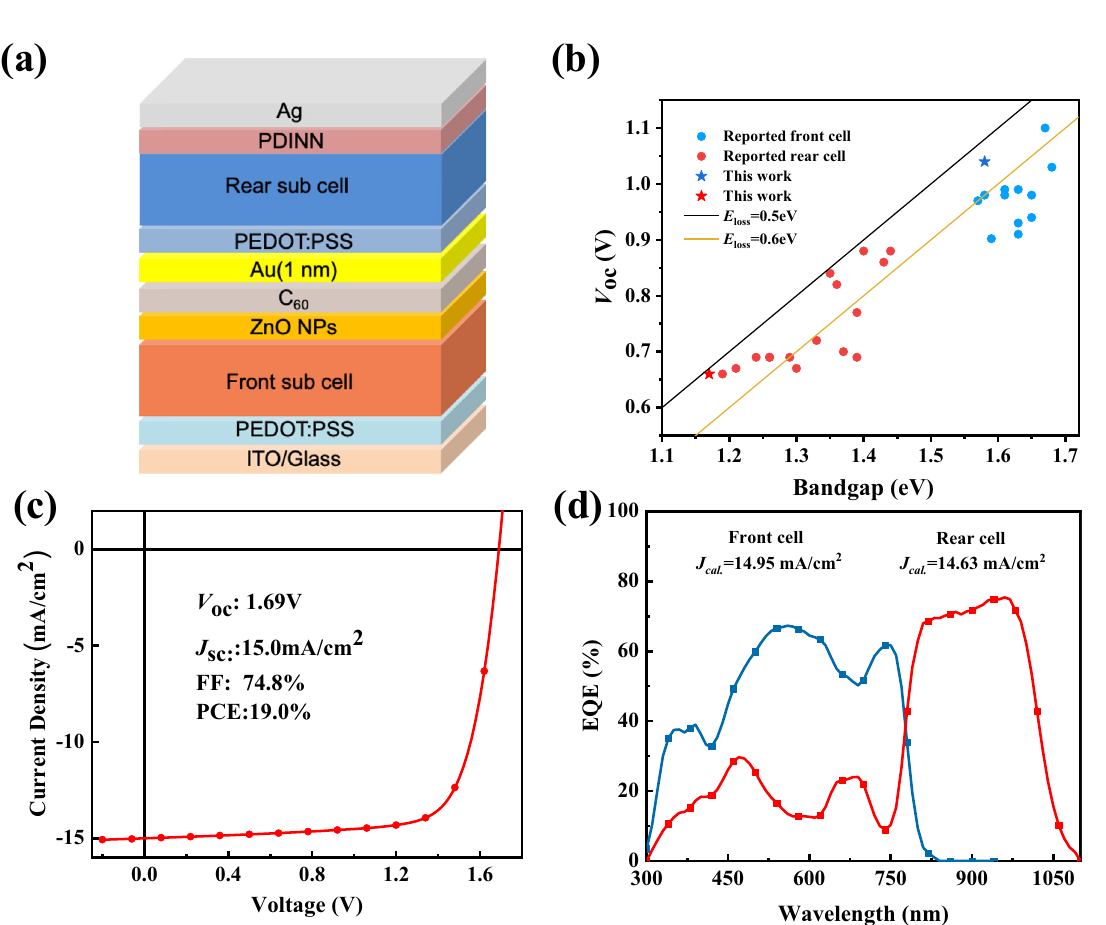
Fig. 4 | Device structure and photovoltaic performance of the TOSCs. a Device architectureoftheTOSCs. b Plotsof V oc oftheOSCsvs E g opt oftheacceptorsusedin the front cell and rear cell of the TOSCs reported in literatures. c J – V curves of the